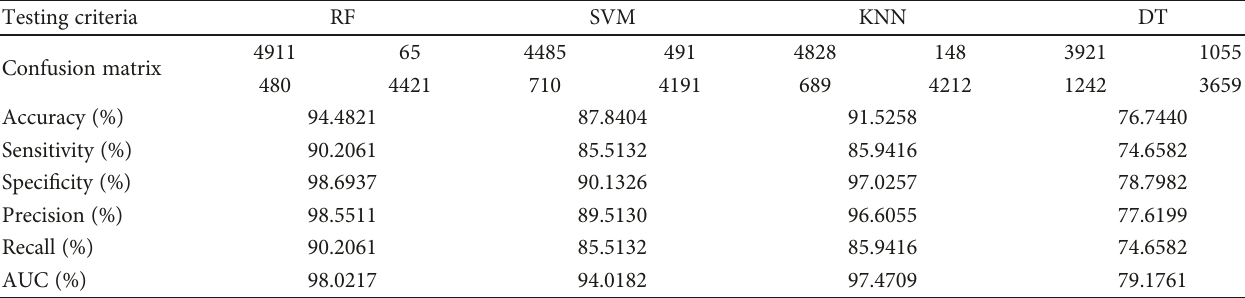
Table 9: Performance measures of the classi fi ers for MSM dataset.